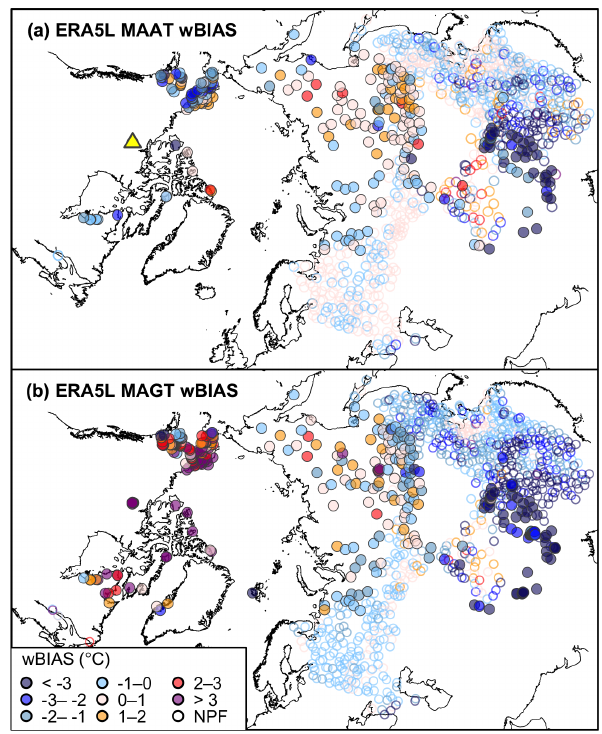
Figure 1. Comparison of ERA5L MAAT (a) and MAGT (b) with observations. wBIAS is calculated using all available MAGTs from the four soil layers. Filled circles represent locations underlain by permafrost, and unfilled circles represent locations not underlain by permafrost (NPF) based on the IPA map. The yellow triangle in (a) marks the location of Lac de Gras, where the detailed permafrost simulation is